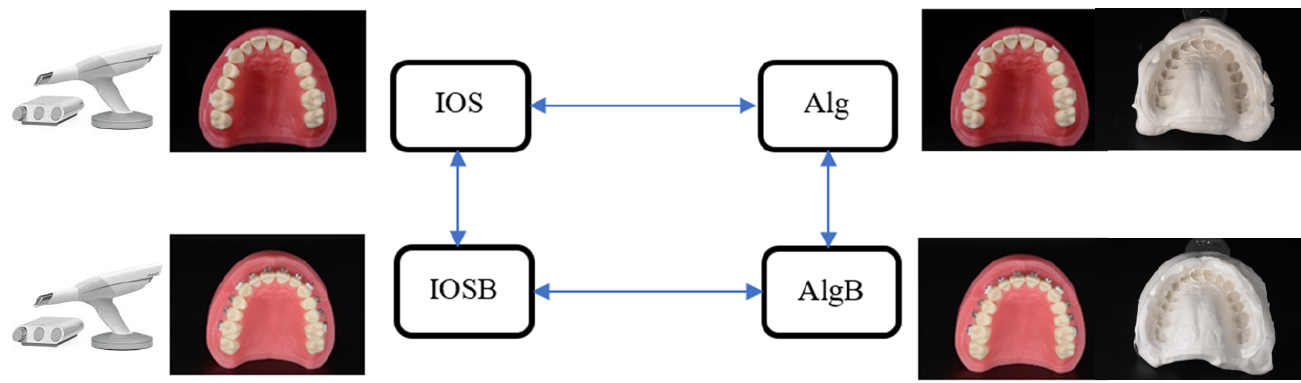
Figure 4. The chart shows a comparison between the groups. IOS = intraoral scanner (TRIOS3 ® ) in model without orthodontic brackets, IOSB = intraoral scanner (TRIOS3 ® ) in model with orthodontic brackets, Alg = alginate impression in model without orthodontic brackets, AlgB = alginate impression in model with orthodontic brackets.